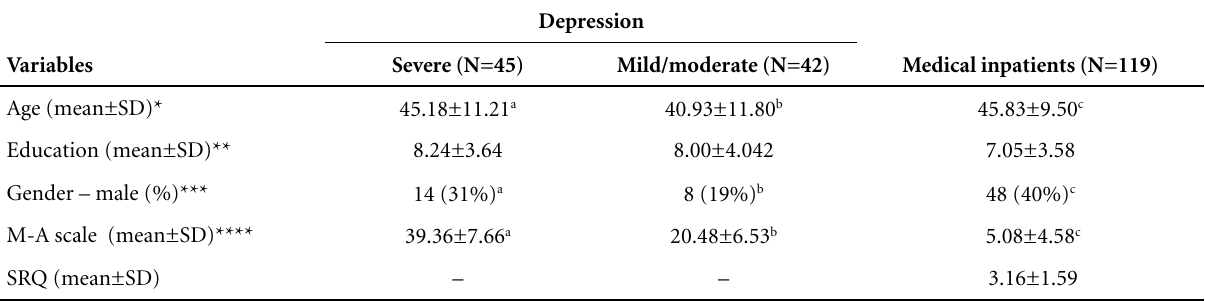
Table 1. Demographic data from major depression and medical